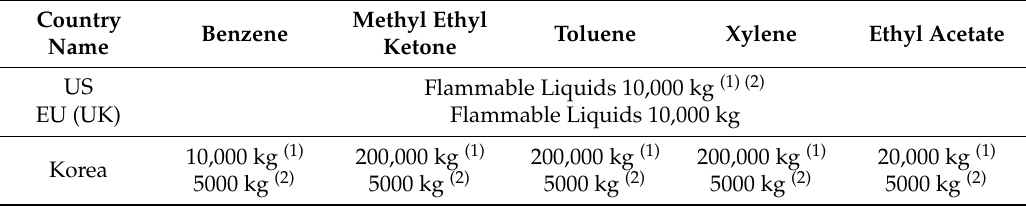
Table 2. Comparison of designated quantity of accident prevention system of chemicals by